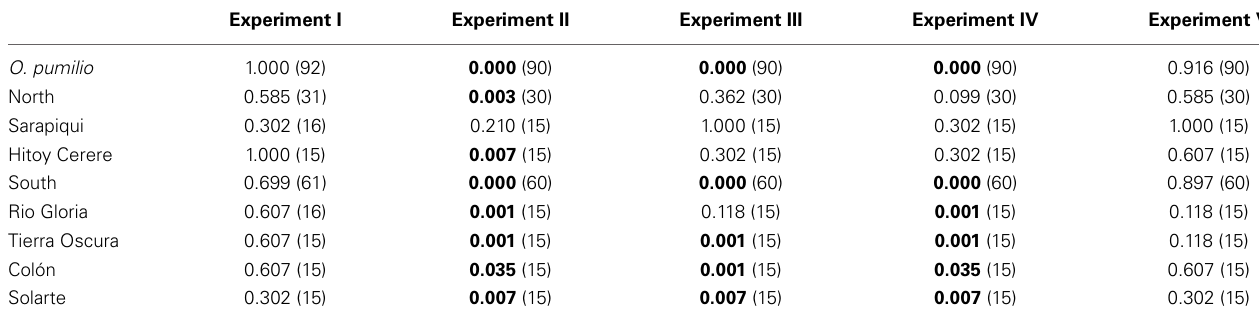
Table 1 | Results ( P -values) of binomial tests including sample sizes ( N